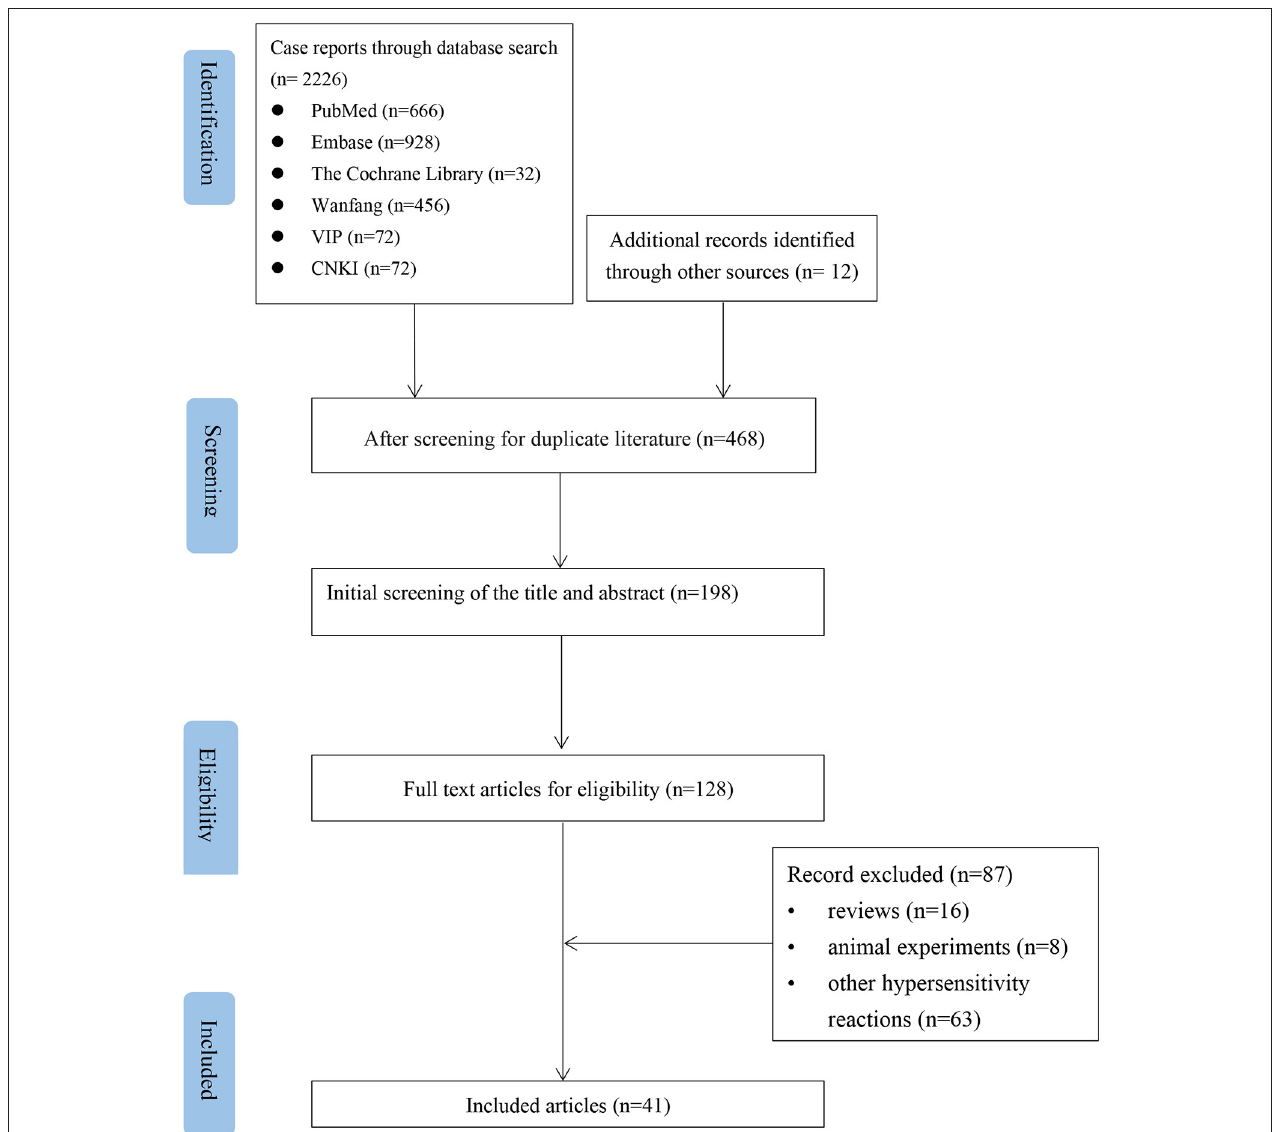
FIGURE 1 | Flow chart of the study selection process for reported cases of NSAIDs-induced Kounis